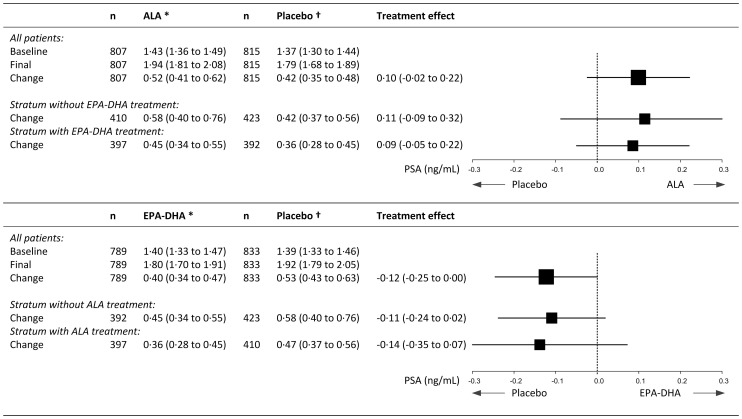
Effect of ALA supplementation on prostate specific antigen (PSA) concentrations (ng/mL) of 1622 male patients.Values are means (95% confidence interval). ALA = alpha linolenic acid, EPA = eicosapentanoic acid = EPA, DHA = docosahexanoic acid. For the two comparisons of ALA vs. placebo the test of heterogeneity was non-significant (Q-value 0.054; I-squared 0.000; P = 0.82), similar to the comparisons of EPA-DHA vs. placebo (Q-value 0.052; I-squared 0.000; P = 0.82).